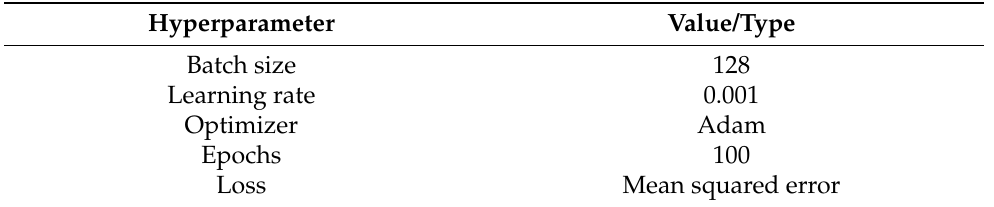
Table 1. Hyperparameters related to training.